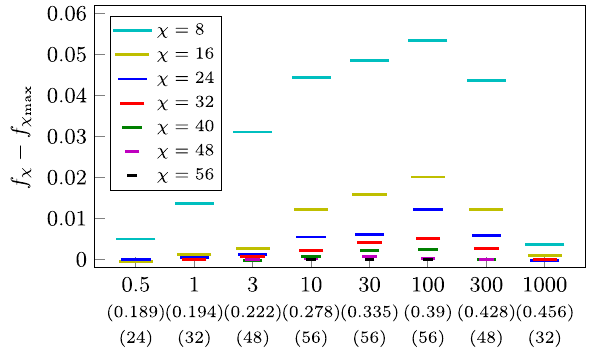
FIG. 13. Decoder convergence for the rotated 33 × 33 surface code, represented by shifted logical failure rate f χ − f χ function of χ at a physical error probability p near the threshold for the given bias η . Each data point corresponds to 30 000 runs with identical errors generated across all χ for a given